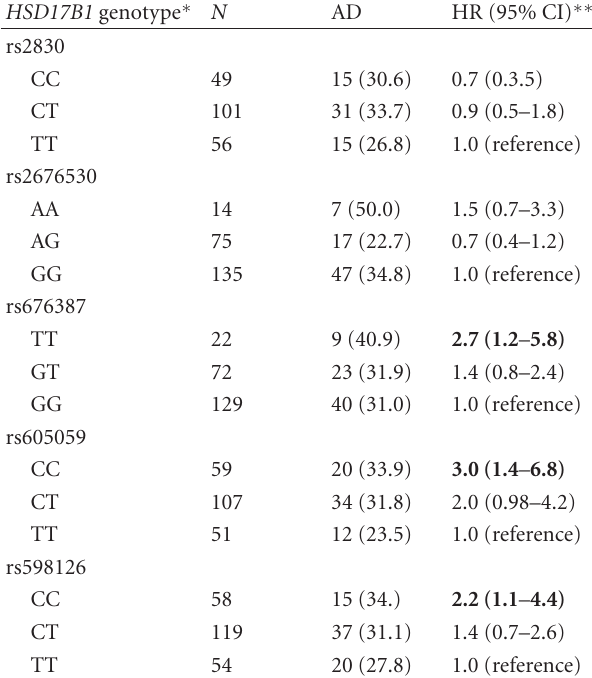
Table 3: Alzheimer’s disease risk by HSD17B1 genotype in women with Down